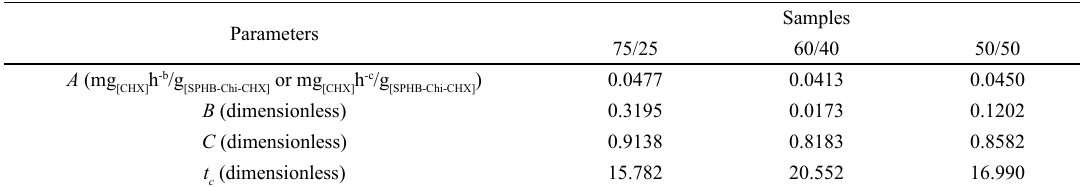
Table 1. Parameters values of Equations 3 and